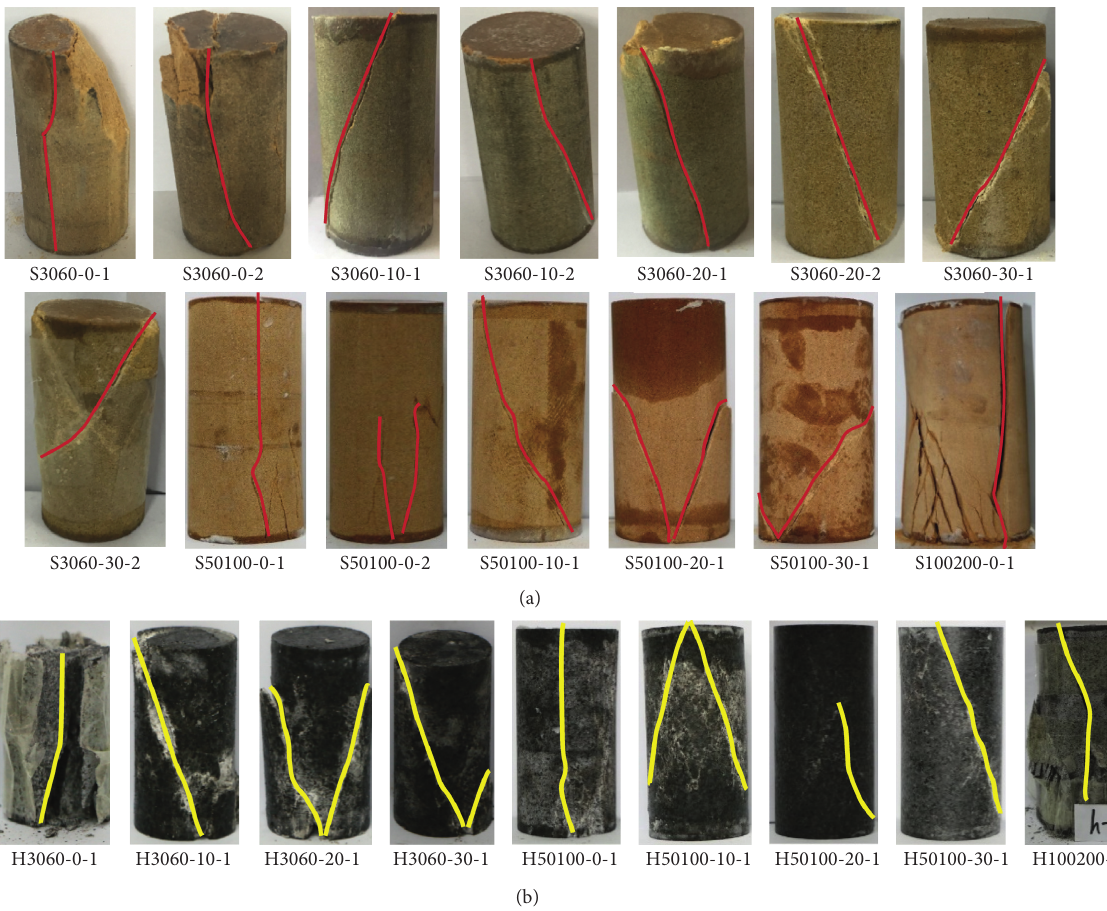
Figure 5: Crack image of failed specimens. (a) Sandstone specimens. (b) Granite specimens.